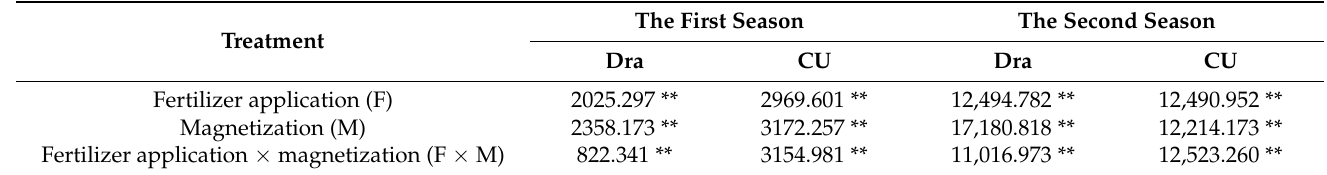
Table 2. The effects of fertilizer application and magnetization on the Dra and CU under different seasons.